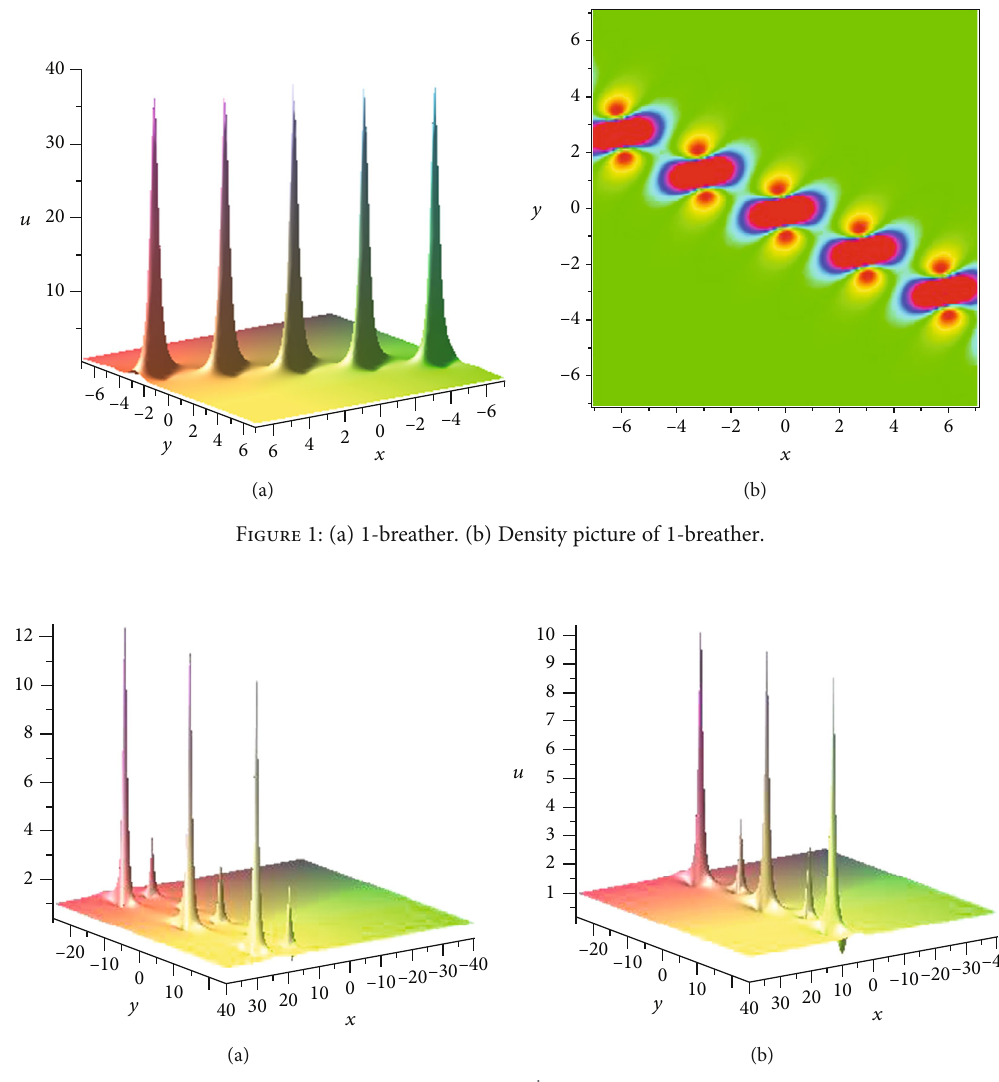
Figure 2: Propagation of 2-breather for L